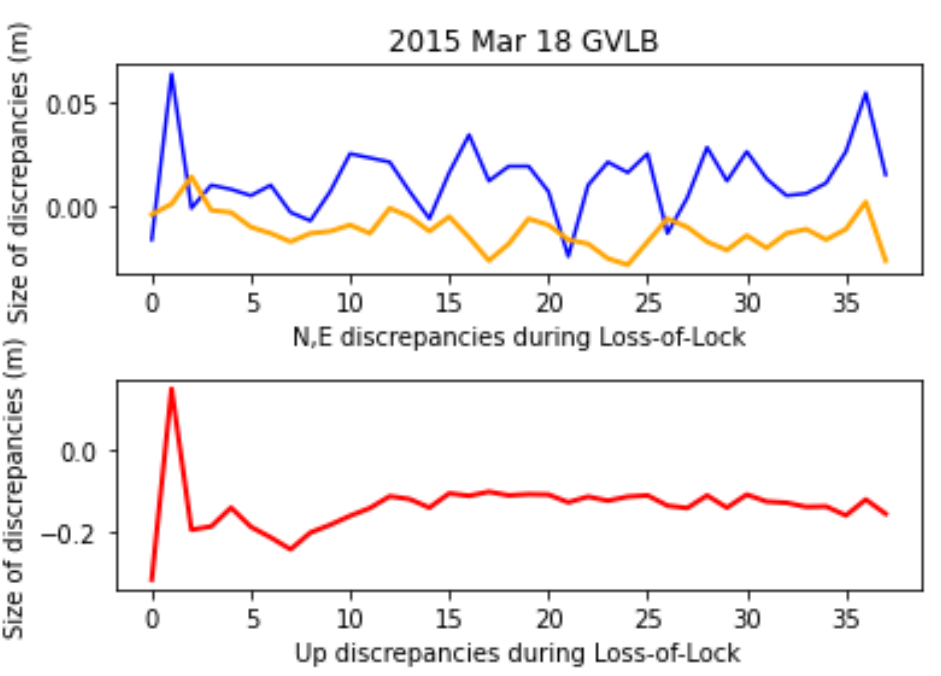
Figure 17. Typical plot of 90 s sequential discrepancies of RIMS station, GVLB N (blue), E (orange), Up (red). No. of sequential 90 s events on the x-axes. Event No. 64 in Tables S13 and S14, correspondingly. No. of sequential recurrence of loss of lock on x-axes.